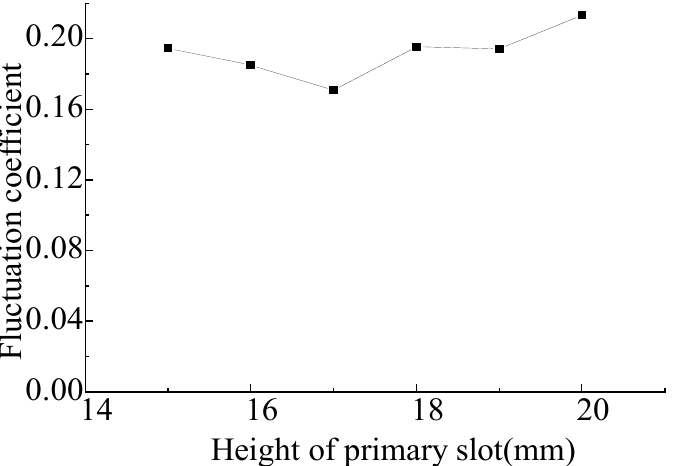
Figure 16. Relationships between output power and efficiency with the height of primary slot.